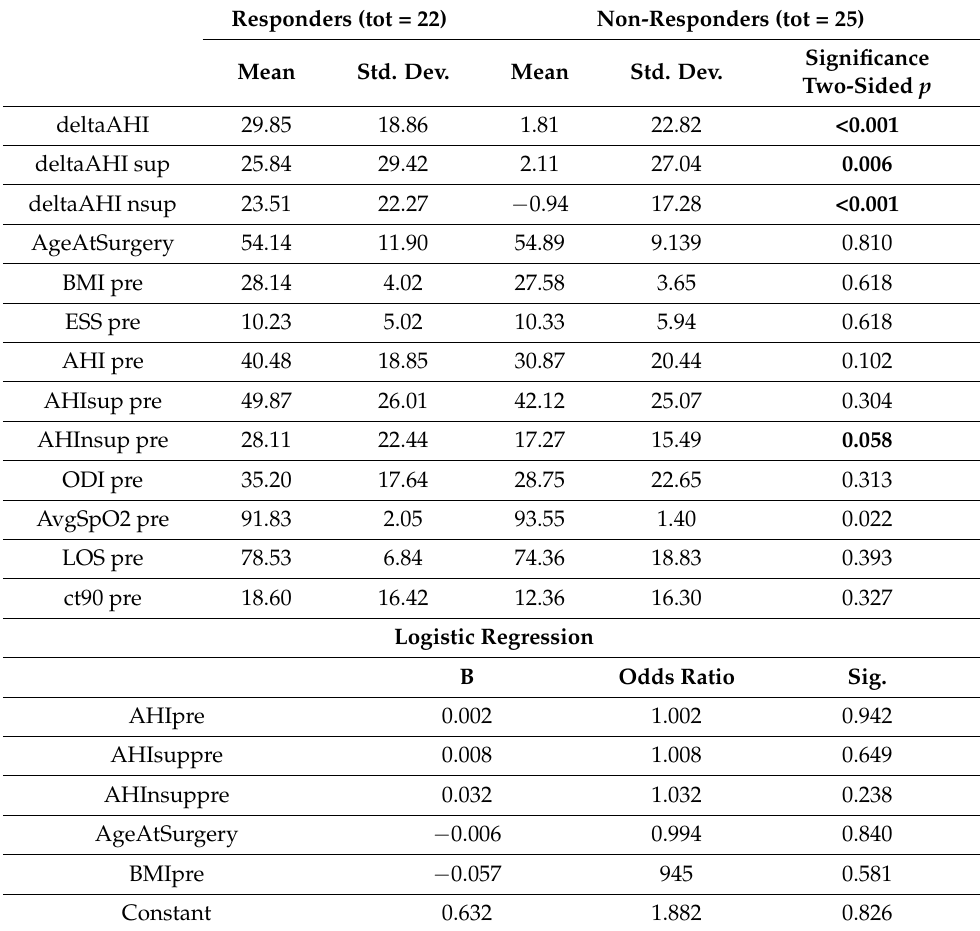
Table 2. Comparative analysis between responders and non-responders (Independent t -test). Logistic regression to test the influence of preoperative parameters on success is also shown.